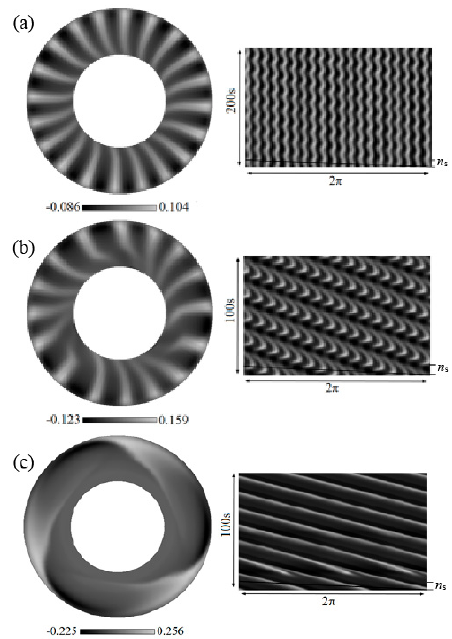
Figure 12. Surface pattern transitions with the increase of crystal rotation rate, the left is the concentration oscillation and the right is the corresponding when Re T = 6.0 × 10 3 . ( a ) Re s = 1403; ( b ) Re s = 1870; ( c ) Re s = 3506.